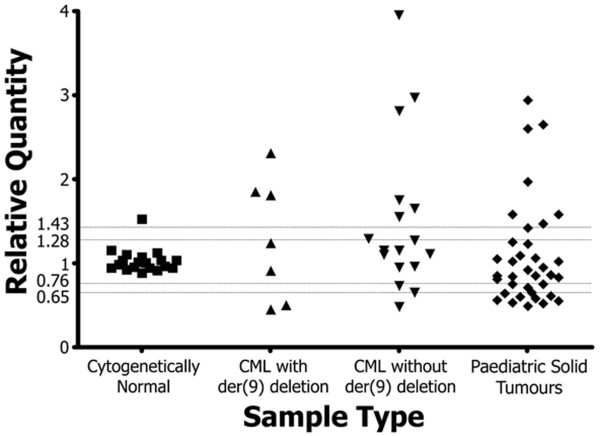
A graphical representation of real-time polymerase chain reaction results.